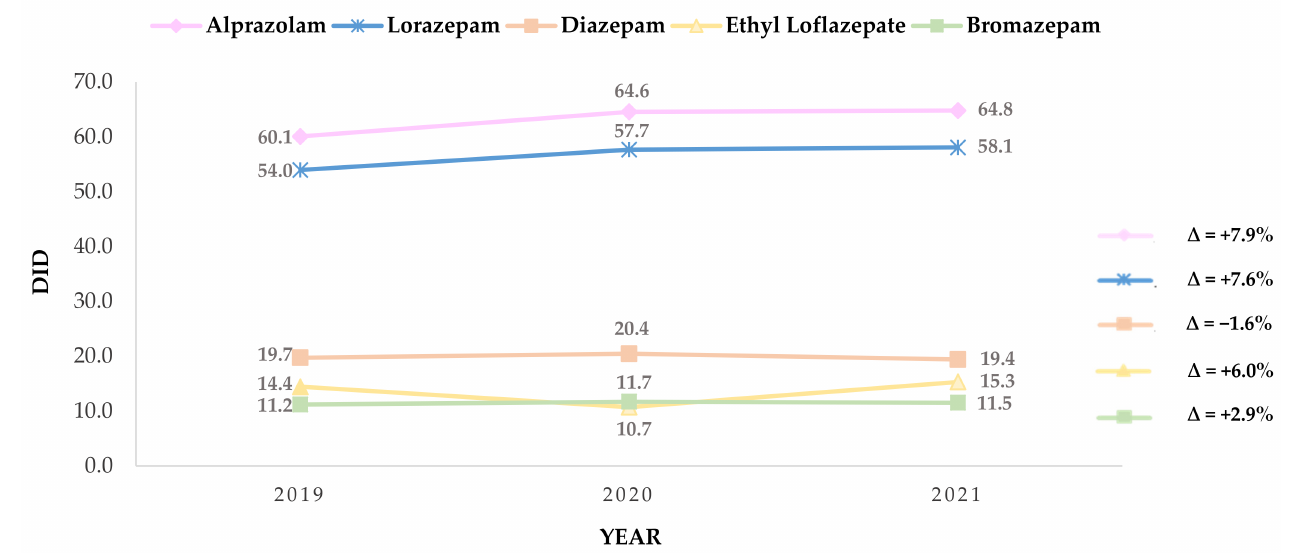
Figure 3. Prescription and variance (%) over the years of alprazolam, lorazepam, diazepam, ethyl loflazepate, and bromazepam, expressed in DDD per 1000 older adult inhabitants per day